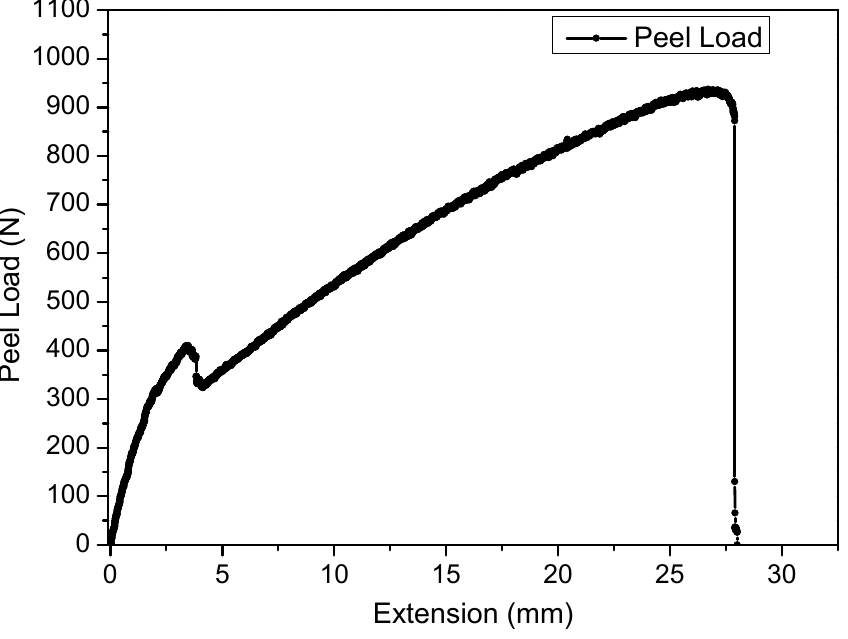
Figure 13. Result of the peel test at 8 kJ of discharge energy.